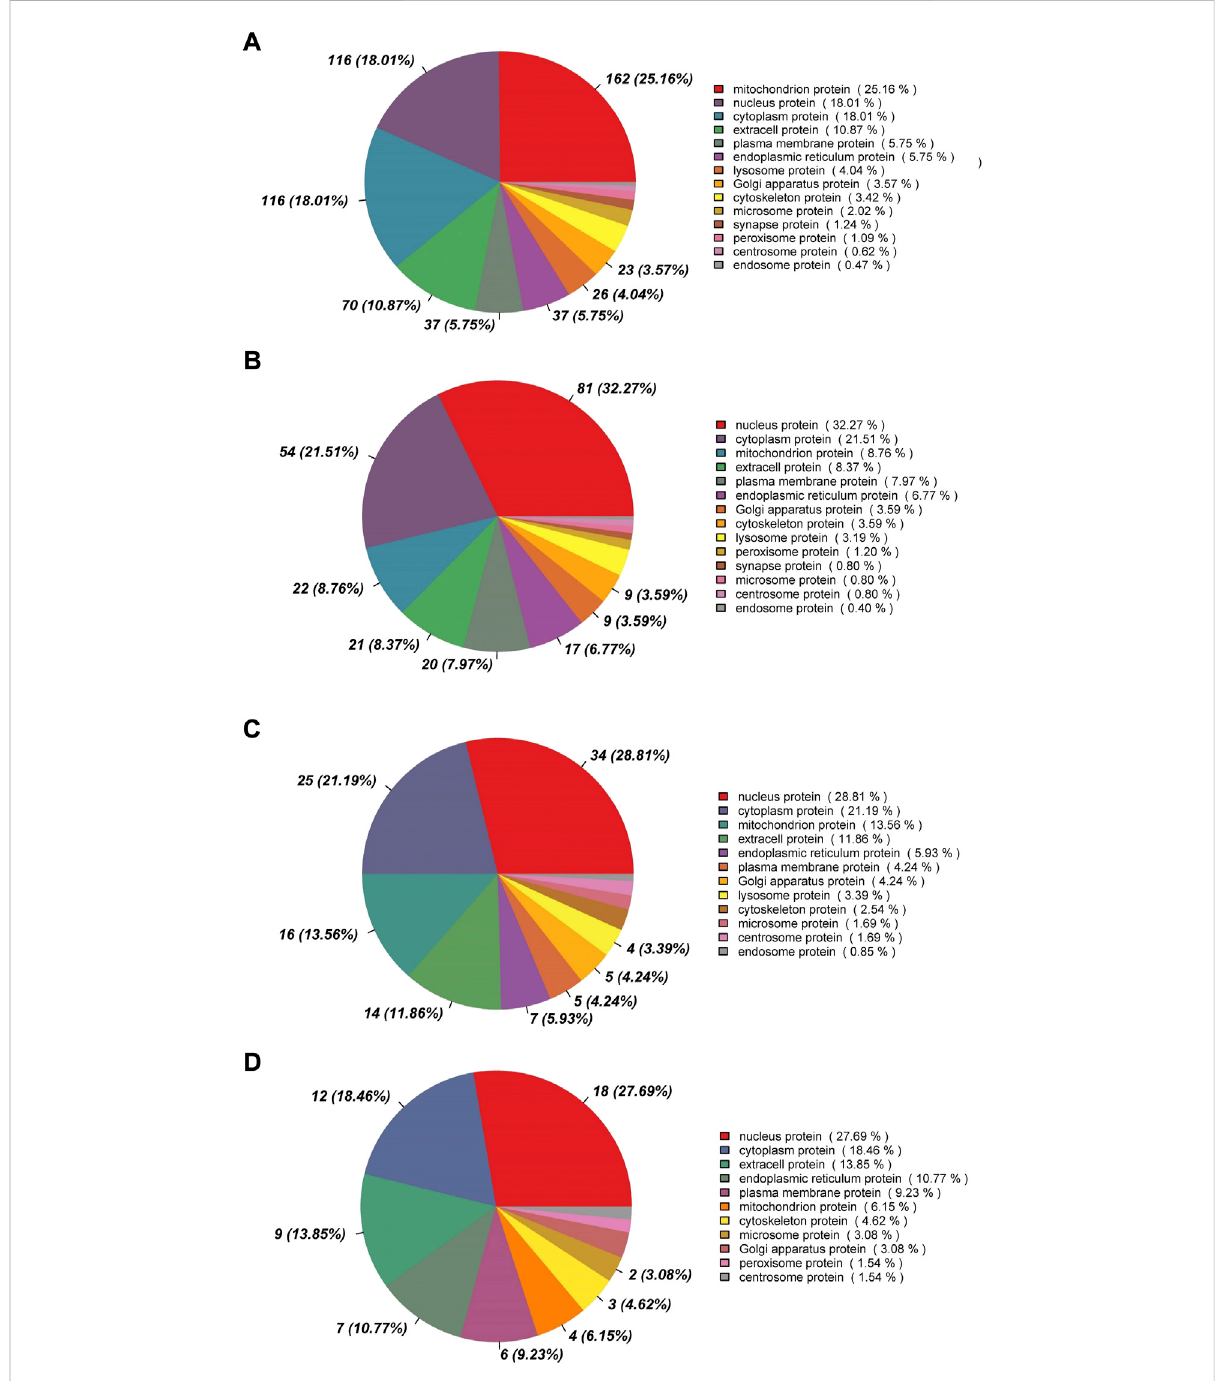
FIGURE 3 Subcellular localization analysis of differentially abundant proteins in rumen epithelium between (A) day 0 and day 15, (B) day 15 and day 30, (C) day 30 and day 45 and (D) day 45 and day 60 of